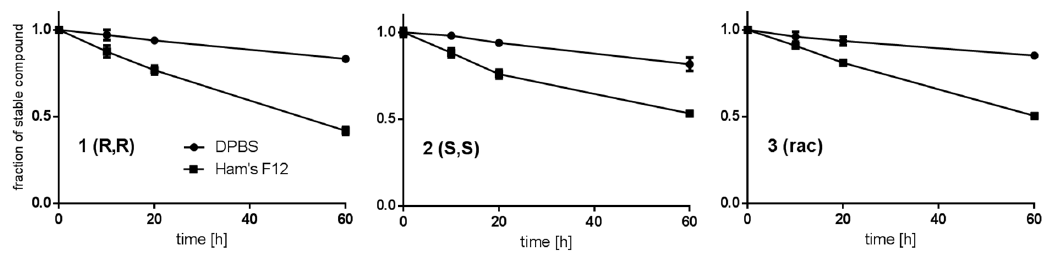
Figure 3. Stability of 1 , 2, and 3 in Dulbecco’s phosphate-buffered saline (DPBS) and Ham’s F12 cell culture medium at 37 °C. Error bars represent the standard deviation.